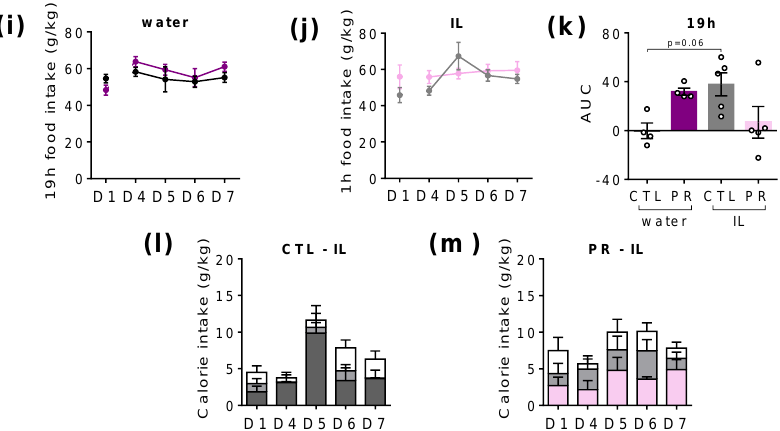
Figure 6. Food intake measurement after water or Intralipid 5% (IL) ingestion in female offspring at postnatal day (PND) 100. Schematic representation of the experiment ( a ): after 5 h-food deprivation, a weighed bottle of water or IL was presented to rats during 15 min then removed. Food pellets were given back and food intake was measured after 1 h, 3 h, 5 h, and 19 h. This sequence was repeated 7 days in a row. IL intake ( b ) each day of the training period. Daily 1 h-food intake after water ( c ) and IL ( d ) preload, and AUC ( e ) in CTL and PR females. Daily 5 h-food intake after water ( f ) and IL ( g ) preload, and AUC ( h ) in CTL and PR females. Daily 19 h-food intake after water ( i ) and IL ( j ) preload, and AUC ( k ) in CTL and PR females. The 1 h-, 3 h-, and 5 h-calorie intakes in CTL and PR females after water ( l ) or IL preload ( m ). Black and purple bars, water; grey and pink bars, IL. Solid line, food intake. Dotted line, IL intake. CTL, control. PR, protein restriction. IL, intralipid. AUC, area under the curve. Data are individual values and mean ± SEM or individual values ( n = 4 – 5). * p < 0.05 vs. CTL, 1-way or 2-way ANOVA with Sidak post-test, unpaired t-test. Once rats were habituated, we measured chow pellets consumption after a preload of water or IL during each day from D4 to D7 over a period of 1 h, 5 h, and 19 h in order to distinguish the early or late response to the preload. Water preload did not modify the first hour of food intake between groups (Figure 6c), whereas IL preload increased food intake during the first hour for the CTL group, but not for the PR females ( p < 0.05; 2-way ANOVA; Figure 6d). The overall consumption from D4 to D7 did not show significant As we observed that food behaviour is affected in PR females, we performed c-fos differences (Figure 6e). Over the 5 h period, CTL rats presented a significant increase of staining in several hypothalamic areas involved in food intake control after a 5 h fast, i.e., food intake between D1 and D4 ( p < 0.05; 2- way ANOVA followed by Tukey’s test) , while basal state (Figure 7a – e), and 1 h exposure to water or IL to assess the effect of lipids on the food intake of PR females was not changed when the preload was water (Figure 6f). the activity of hypothalamic cells (Figure 7f – k). After the IL preload, the 5 h period of food intake was significantly increased over time ( p < 0.05; 2-way ANOVA) but not different between the CTL and PR groups (Figure 6g). AUC tended to be lower for PR females after water preload and was not changed after IL RC preload (Figure 6 h). Over the 19 h period, food intake was significantly increased after water or IL preload in both groups ( p < 0.05; 2-way ANOVA; Figure 6i,j). AUC was higher for PR females after water preload and tended to be lower after IL preload ( p < 0.05; 1-way ANOVA; Figure 6k). This suggests that the first phase of lipid sensing seemed more effi- cient in PR females. In addition, after lipid preload, the third hour of food intake was more important in PR females ( water: 2.7 ± 1.1%; IL: 23.3 ± 4.6% of the total food consumption; p < 0.05; Figure 6m) than in CTL females ( water: 5.1 ± 2.6%; IL :13.2 ± 5.5% of the total food consumption; non-significant; Figure 6l), suggesting that the satiety period was reduced in the PR group.